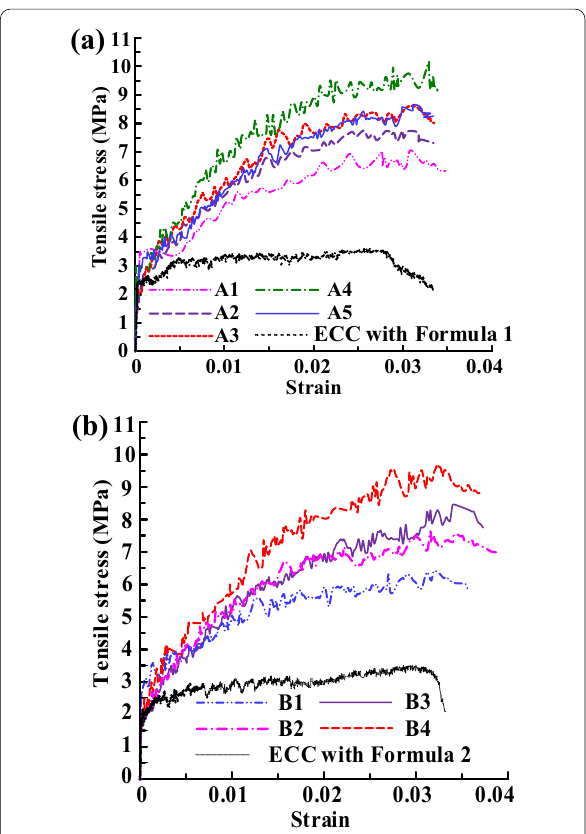
Fig. 6 Tensile stress–strain curves of ECC and HSSSWR-reinforced ECC specimens in a group A and b group B.